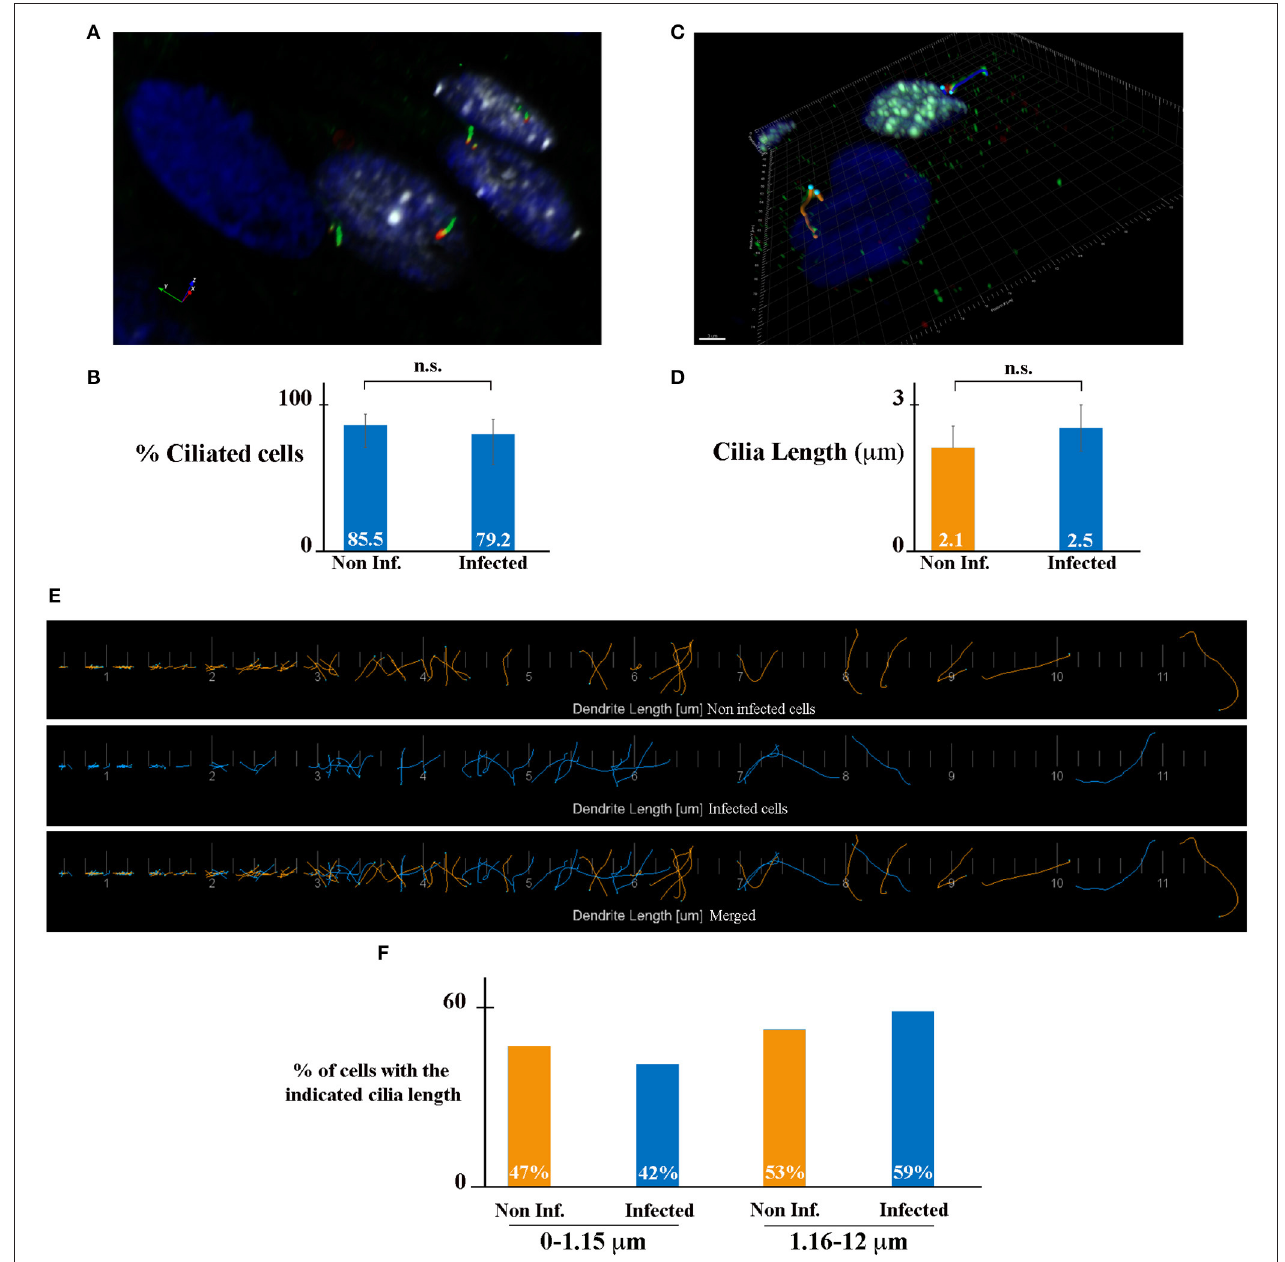
FIGURE 2 | HCMV does not affect ciliogenesis of HK-2 cells. (A) SIM image of HCMV-infected polarized HK-2 cells immunostained for IEA (white), acetylated tubulin (PC axoneme marker, green), and γ -tubulin (PC basal body marker, red). Nuclei were subsequently stained with DAPI. (B) Percentage of ciliated cells of non-infected and infected HK-2 cells. (C) Representative 3D image of ciliated non-infected (blue nucleus) and HCMV-infected (white nucleus) HK-2 cells. The length of PC of each cell was visualized with acetylated tubulin and γ -tubulin and measured with Imaris Software. Scale bar represents 3 µ m. (D) Quantification of cilia length in non-infected and infected HK-2 cells. PC length of 150 cells per condition was measured. n.s, non-significant (Student’s t -test). (E) Visualization of every PC from non-infected (orange) or infected (blue) cells (separately and merged) listed in increasing order. (F) PCs were separated based on their length in two categories (0–1.15 µ m) and (1.16–12 µ m). Percentage of PC in these two categories in non-infected and infected cells. Three independent experiments were performed and statistical analysis was achieved as explained in the materials and methods section. n.s, non-significant (Student’s t -test).